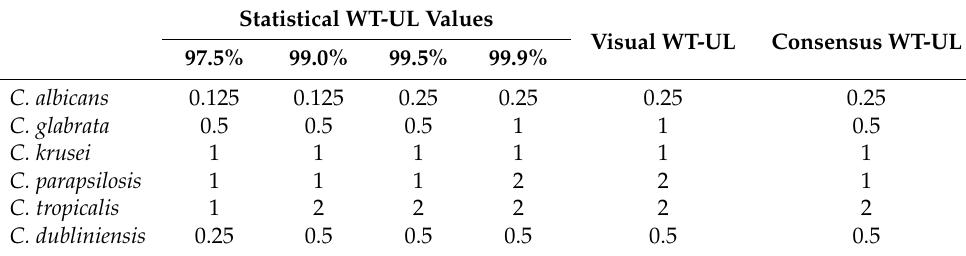
Table 4. Statistical and visual wild-type upper limit values (WT-UL, mg/L) for the five most common Candida spp. determined using the aggregated distributions presented in Table 3, single-centre data for C. dubliniensis and 97.5–99.9% of the modelled MIC